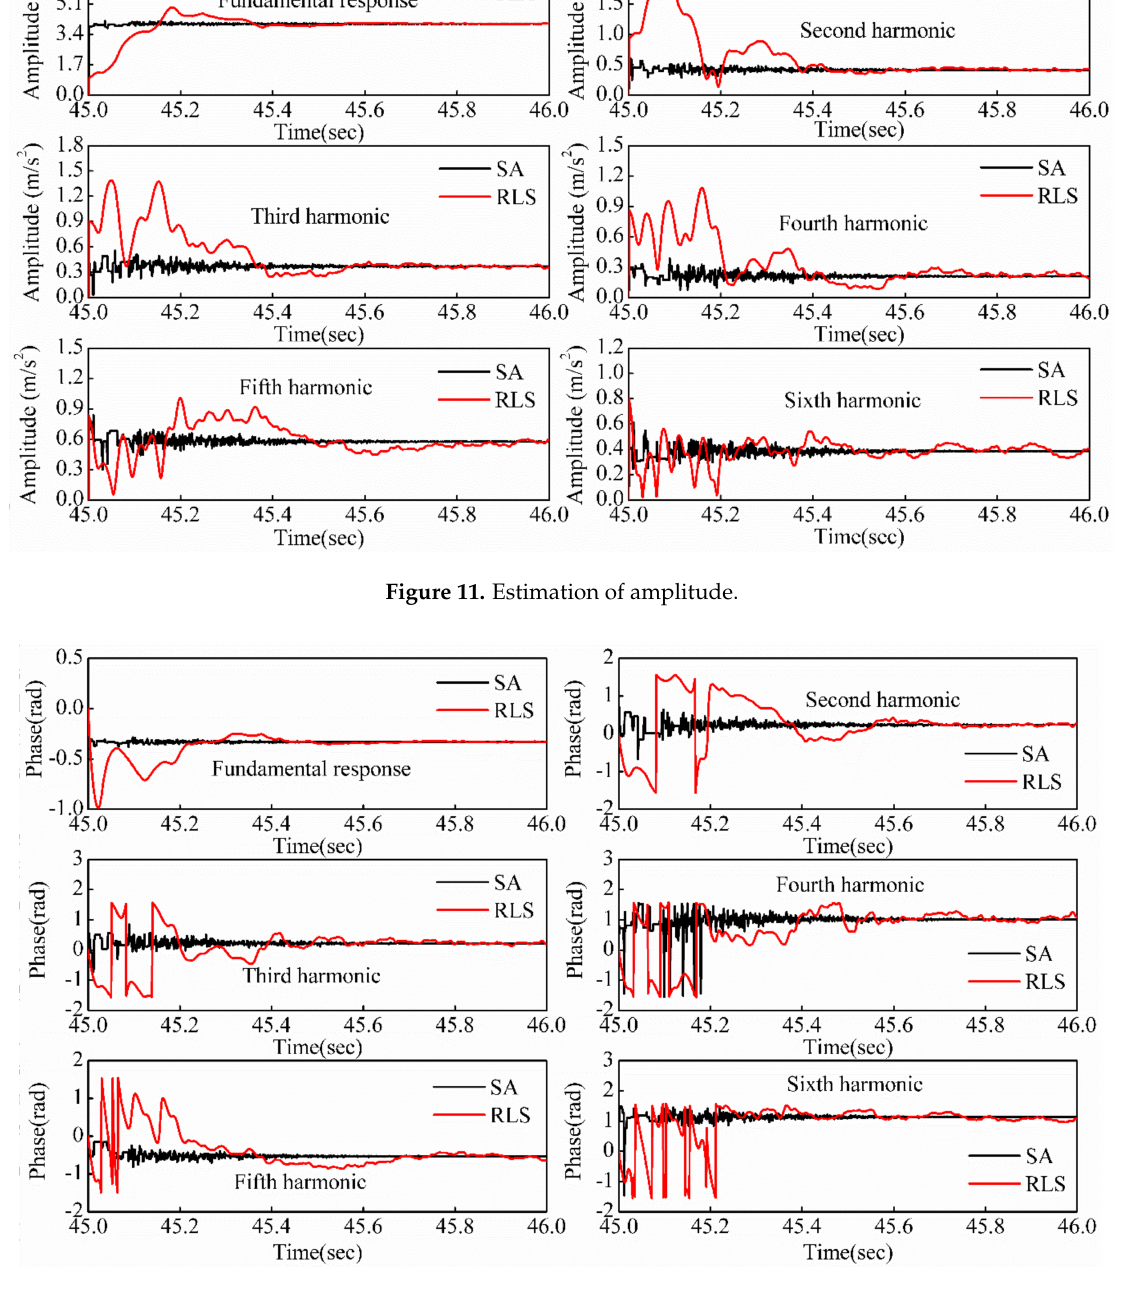
Figure 12. Estimation of